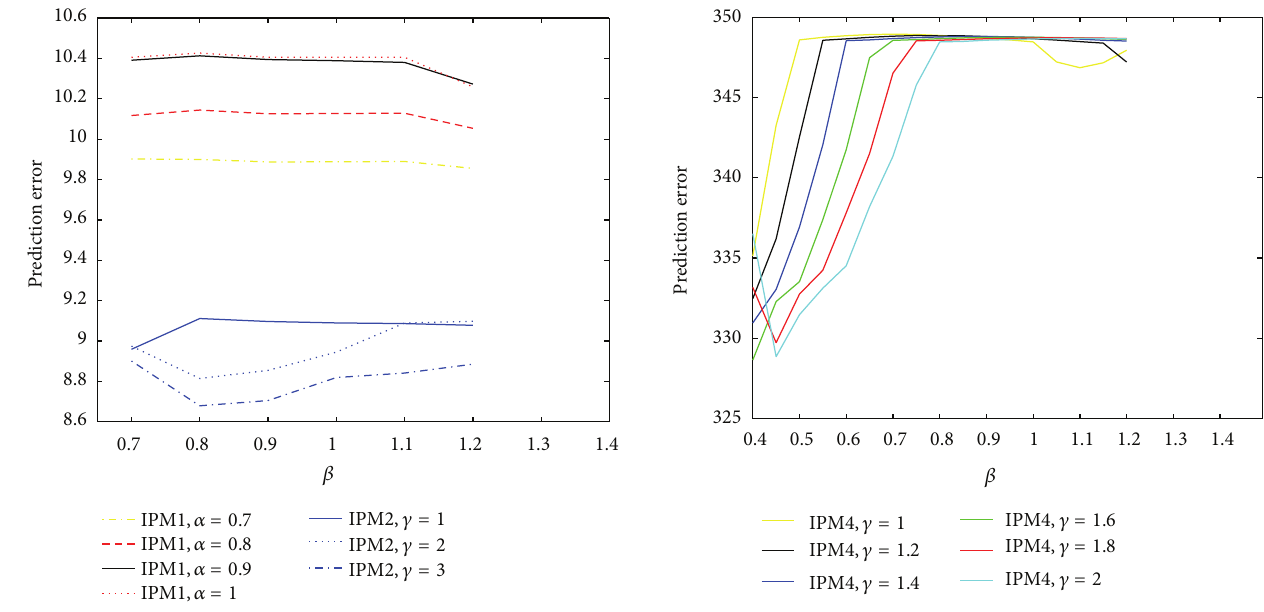
Figure 2: The prediction errors of the new improved parsimonious multivariate Markov chain model with the original convergence condition and the new convergence condition of the new variability in Example 2.